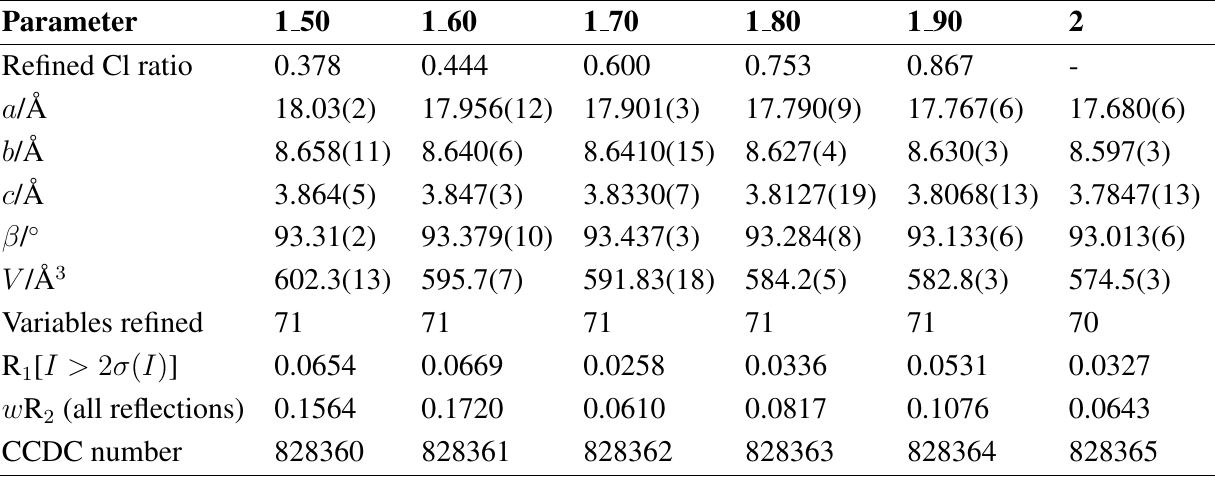
Table 2. Crystal data and refinement results of [ { Cd( µ -Br) crystals measured at 100 K. All crystals were colorless needles and monoclinic in P 2 with Z = 2